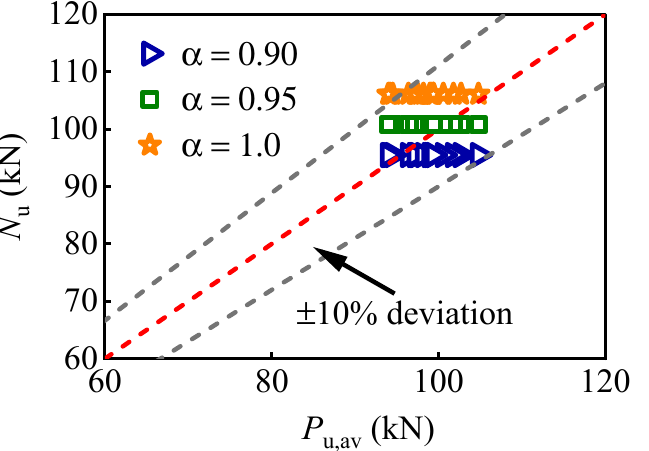
Figure 19. Comparison of the average ultimate shear resistance based on the calculation and FE results.